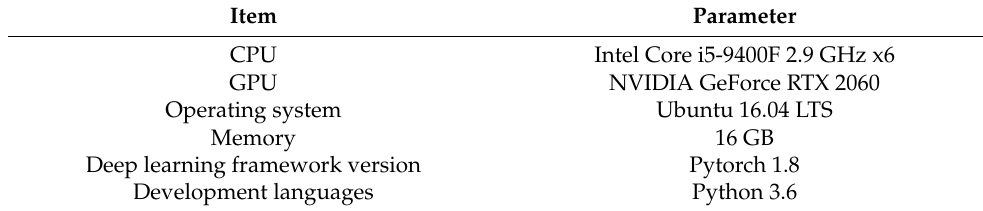
Table 2. Experimental environmental parameters. Figure 6. Example of BDD 100 K-Person dataset.